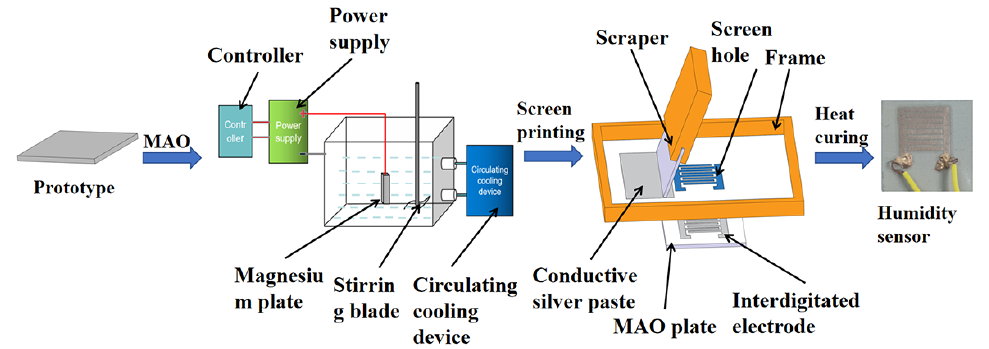
Figure 1. Micro-arc MgO humidity sensor fabrication process.